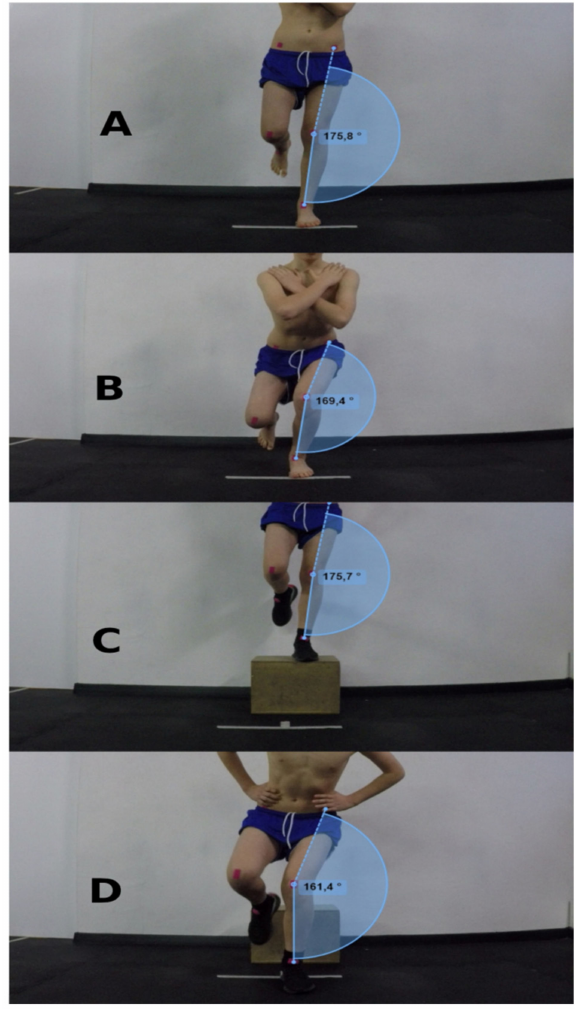
Figure 1. Example of the FPPA 2D assessment of knee valgus in the SLS and SLL tests. ( A , B ) SLS starting angle (176 ◦ ) and end of the test (169 ◦ ), and ( C , D ) SLL starting angle (176 ◦ ) and end of the test (161 ◦